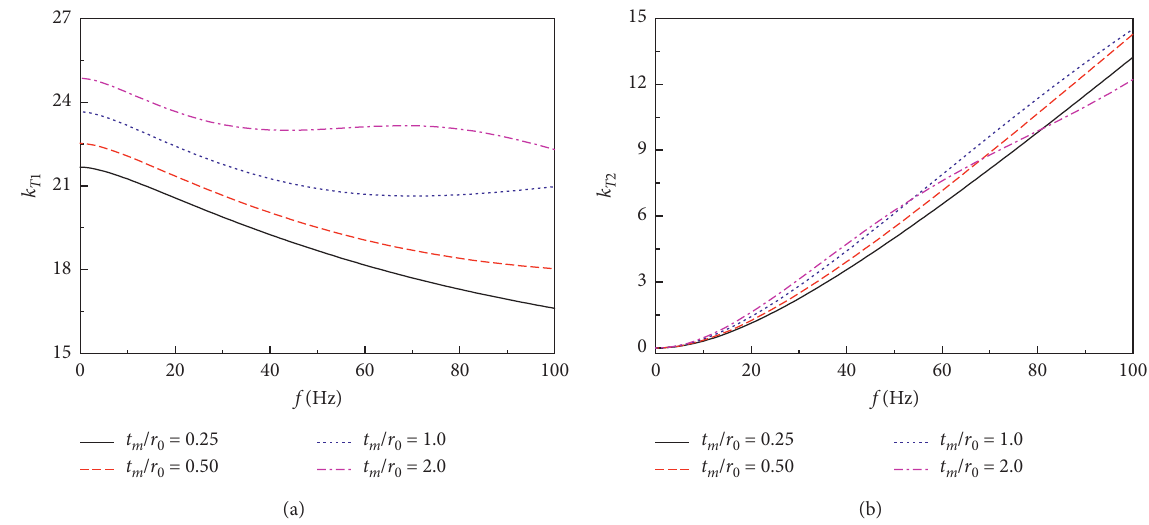
Figure 8: Influence of the disturbance range t GR �